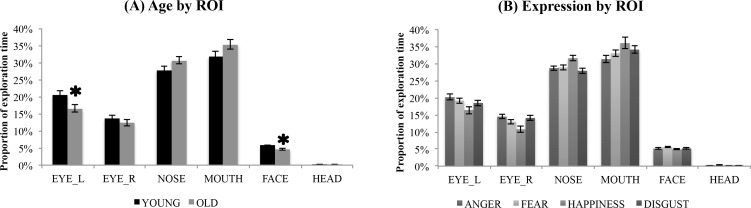
(A) percentage of exploration time by regions of interest and age group; * indicates a signficant group difference (p < .05). (B) percentage of exploration time by regions of interest and emotion. YA = younger adults; OA = older adults; Error bars represent standard error of the mean. Note FACE = face remainder (face minus eye_L, eye_R, nose, mouth); HEAD = hairline/ears.